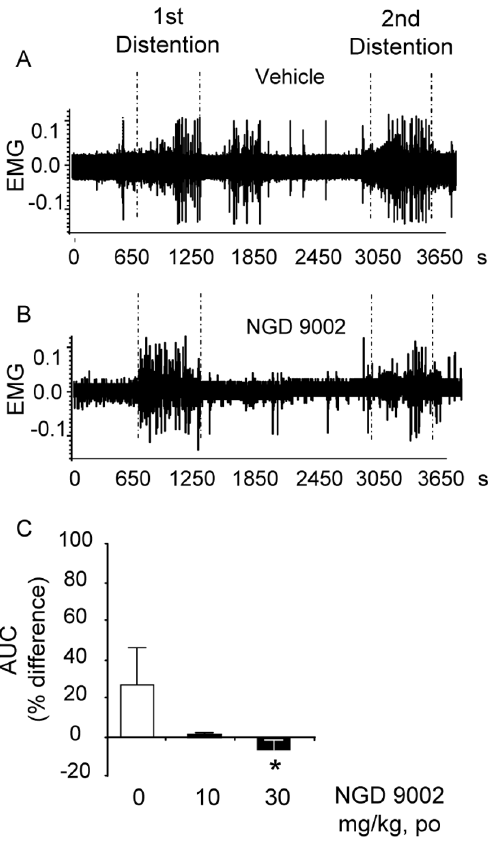
Figure 6. Oro-gastric (og) pretreatment with NGD 98-2 blunts repeated tonic colorectal distention (CRD)-induced visceral sensitization response in conscious rats. Representative trace of abdominal muscle electromyogram (EMG) of rats pretreated with vehicle (A) or NGD 9002 (B). Percent difference in the area under the curve of contraction (AUC) between the 1 st and the 2 nd dissentions is shown in C. Rats were chronically implanted with abdominal electrodes and , 10 days later were pretreated og with vehicle or NGD 98-2 (30 mg/kg). After 30 min of habituation and 10 min basal recording, rats were submitted to the first CRD (10 minutes at 60 mm Hg) followed by a 30 min rest and a 2 nd 10 min distention at 60 mmHg. Values are mean and SEM of percent differences between the first and second responses to CRDs of 9–10 rats/group. *p , 0.05 versus vehicle, t-test or ANOVA, Student-Newman-Keuls.